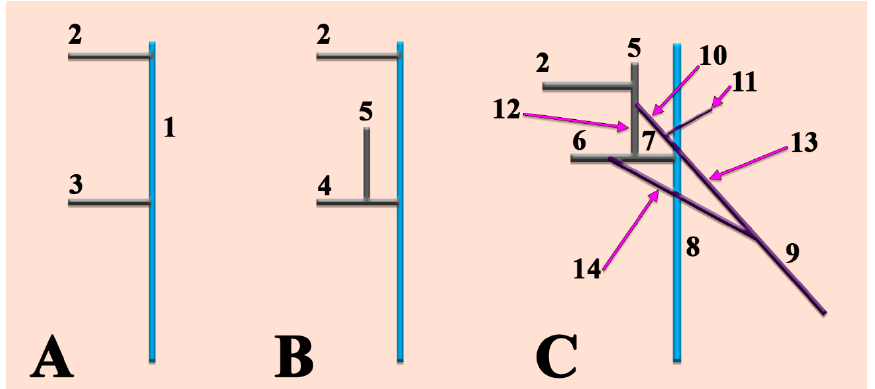
Figure 5. Schematic representation of successive embryonic stages of venous development. ( A ). 10 mm embryo; ( B ).18 mm embryo; ( C ). 40 mm embryo. 1. Precardinal vein; 2. primitive maxillary vein; 3. ventral pharyngeal vein; 4. linguofacial vein; 5. retromandibular vein; 6. proper facial vein; 7. common facial vein; 8. internal jugular vein; 9. external jugular vein; 10. posterior division of the retromandibular vein; 11. posterior auricular vein; 12. anterior division of the retromandibular vein; 13. posterior connection of the external jugular vein; 14. anterior connection of the external jugular vein.